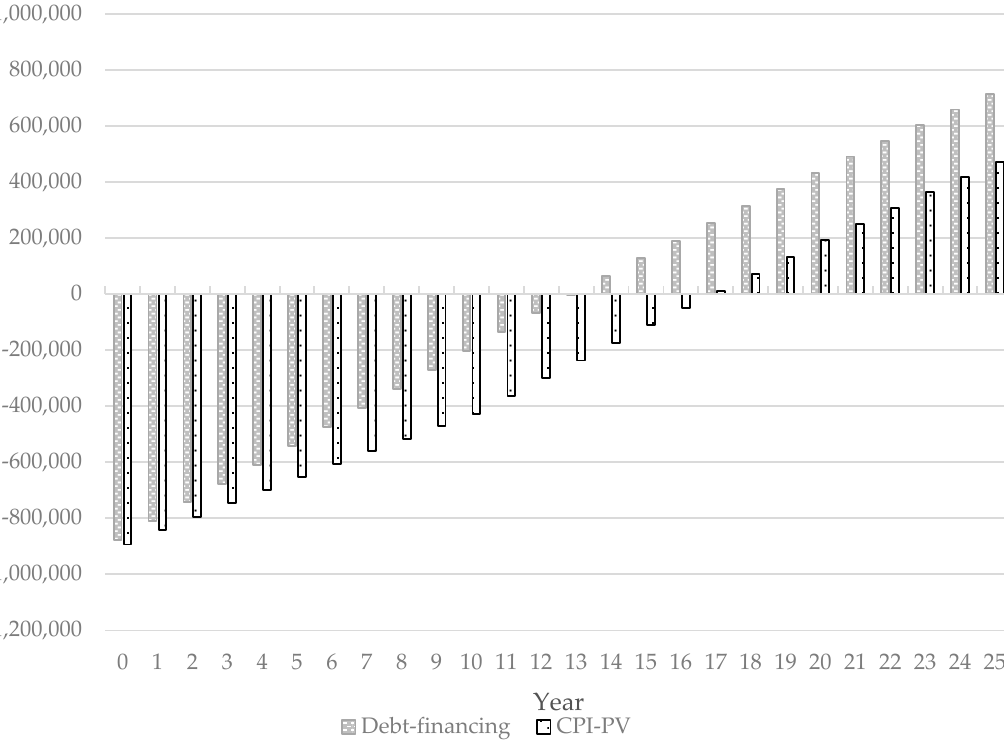
Figure 4. Net present value Case 3, assuming specific costs equal to one single PV power plant.